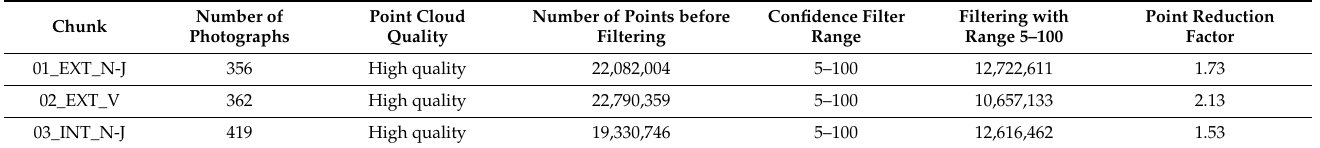
Table 4. Dense point cloud parameters of each building block after confidence level